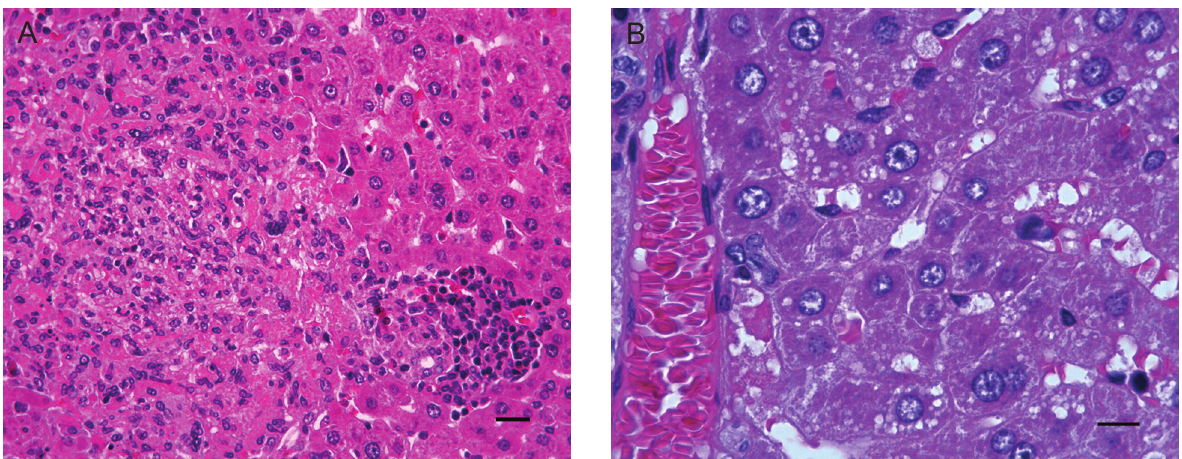
Figure 2. Liver specimen from the cerulein-treated group. A , Hepatocyte necrosis and inflammatory infiltration are visible. H-E, 40X (bar = 20 µm). B , Intracellular vacuolization and vascular congestion are shown. H-E, 100X (bar = 1 µm).